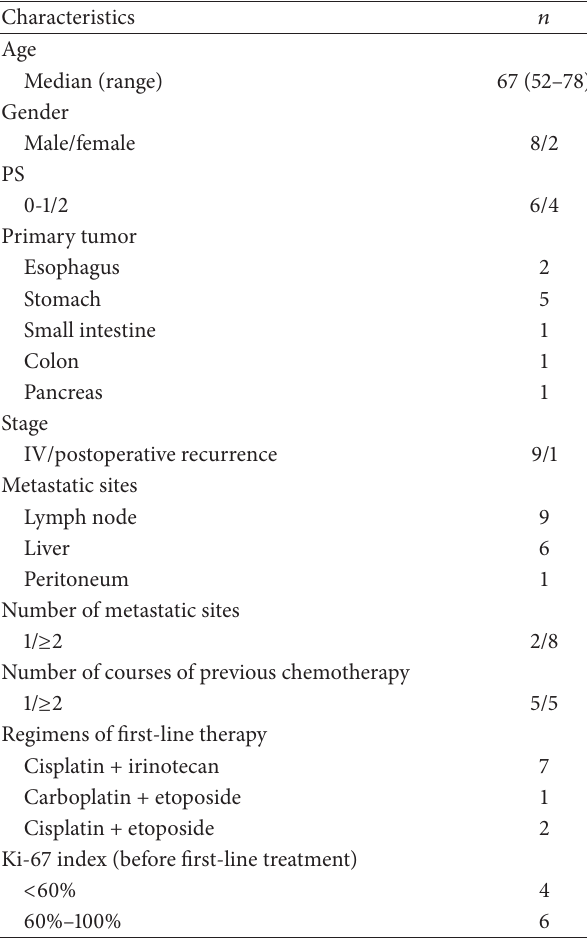
Table 1: Patient characteristics. Table 2: Toxicity.